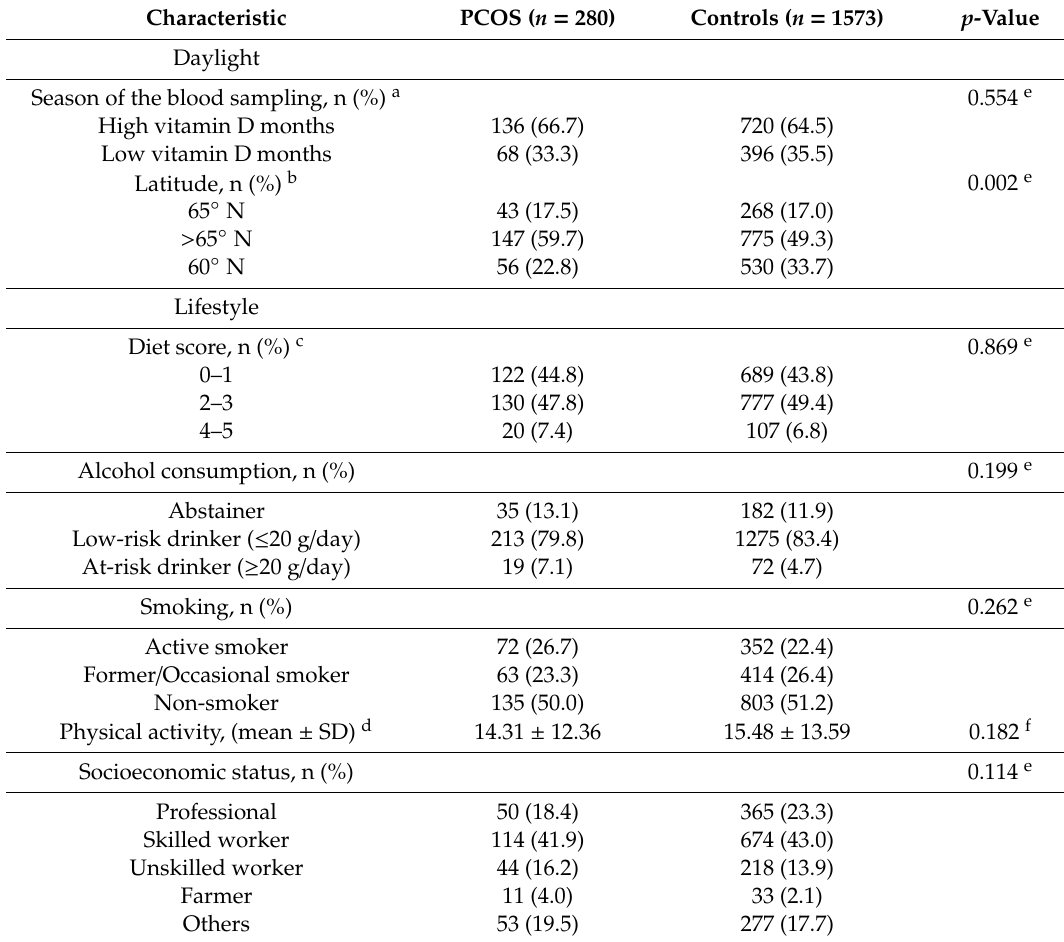
Table 1. Background characteristics of the study participants: women with self-reported polycystic ovary syndrome (PCOS) and non-PCOS controls.